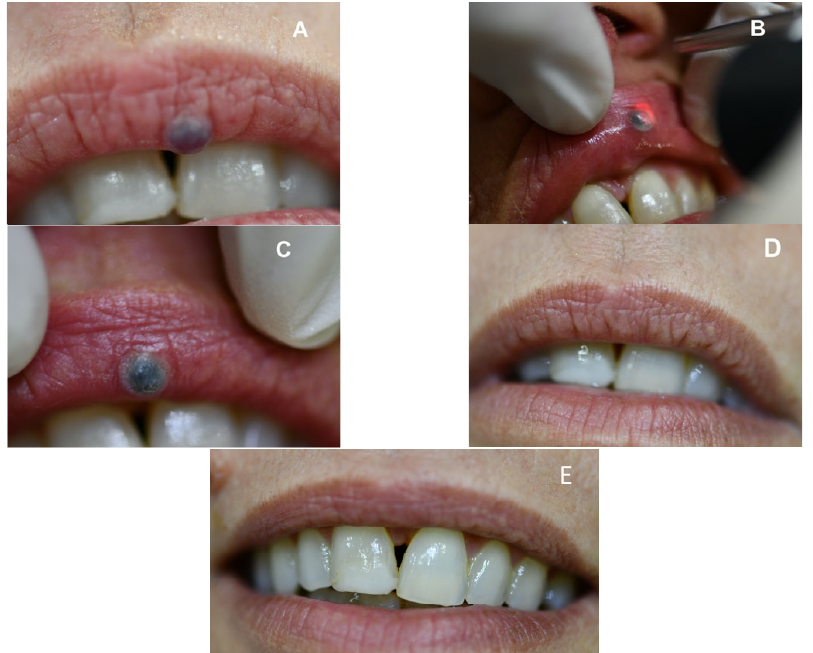
Figure 2. ( A ) Preoperative optical findings; ( B ) laser irradiation of the vascular lesion with no contact technique; ( C ) optical findings just after the laser application; ( D ) 1 week after the treatment; ( E ) 2 years after the treatment.